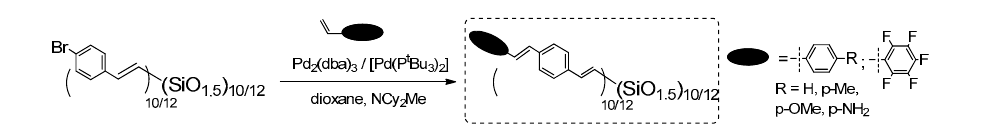
Figure 13. T 10 and T 12 arene derivatives obtained by Heck Coupling and Cross-Metathesis.